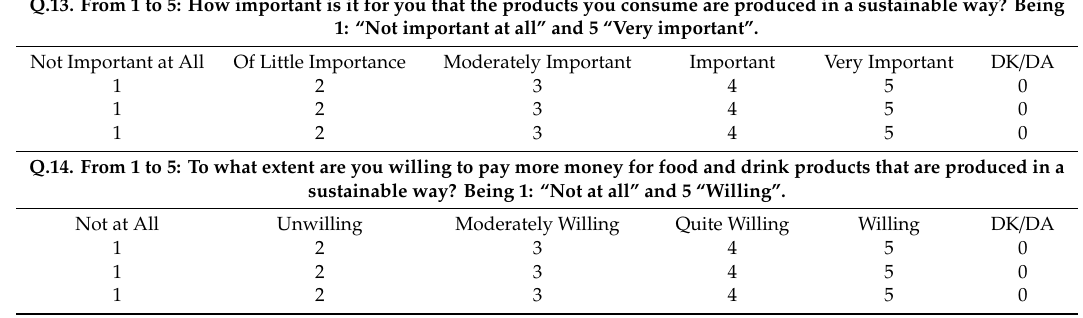
Table A3. Attitudes to Sustainable